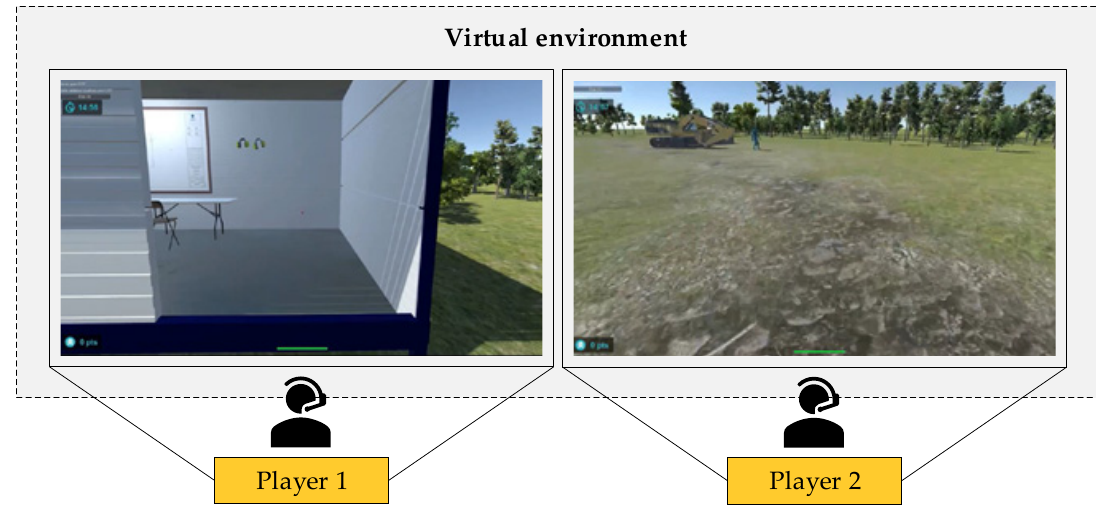
Figure 16. Two characters and two points of view (roles, and actions) for the same VR experience.